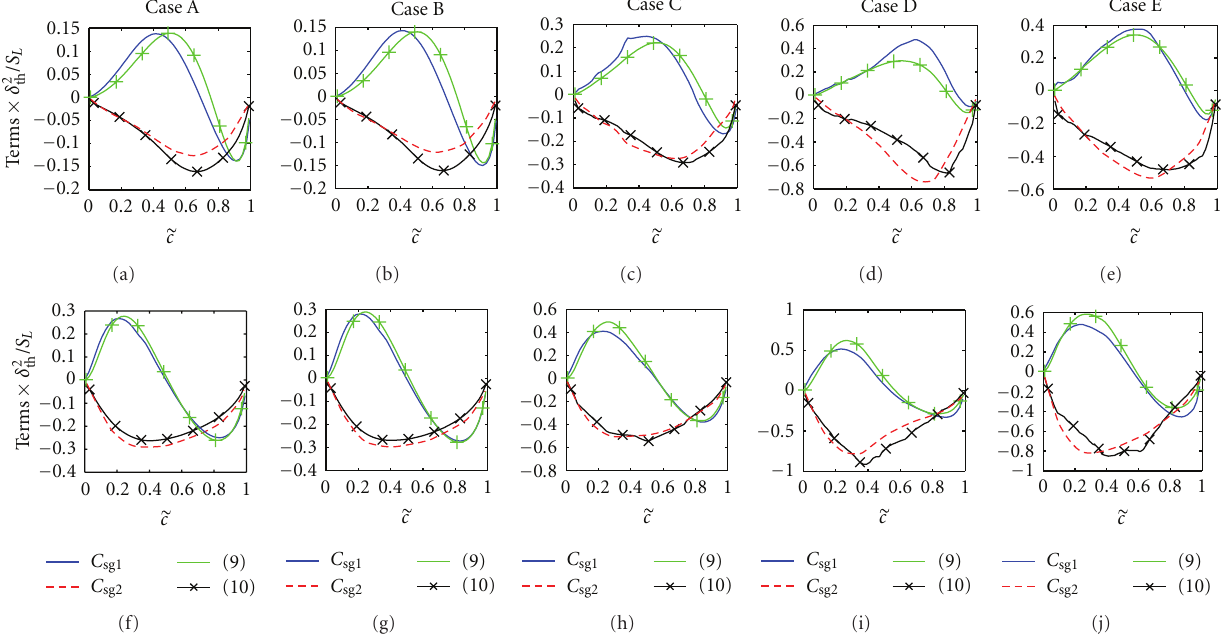
Figure 5: Variations of C sg1 and C sg2 conditionally averaged in bins of (cid:3) c across the flame brush for Δ = 8 Δ m ≈ 0 . 8 δ th (top row) and . 4 δ Δ = 24 Δ m ≈ 2 th (bottom row) for cases A (1st column), B (2nd column), C (3rd column), D (4th column), and E (5th column) along with the predictions of (10) and (12).